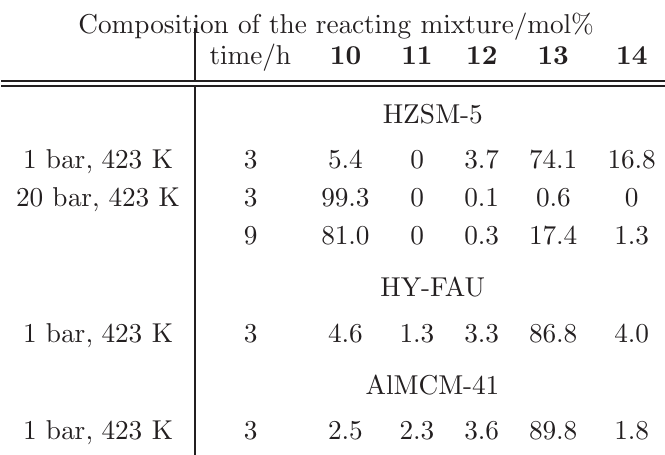
Table 4 Composition of the reacting mixture in an autoclave (30 cm 3 ) in the transformations of thiirane ( 10 ) at 423 K over various molecular sieves (catalyst 100 mg, starting mixture: 2 cm 3 of 10 and 2 cm 3 of CH 2 Cl 2 ).